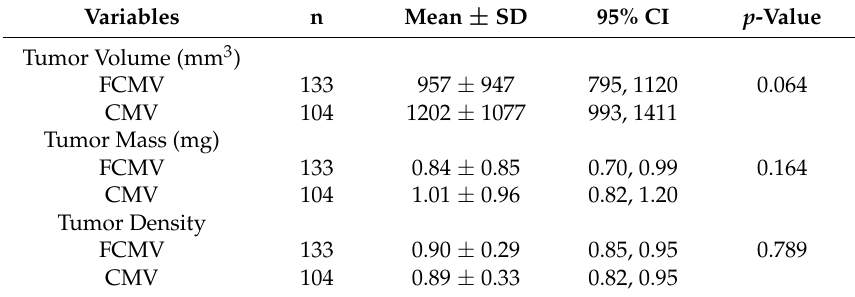
Table 1. The average tumor volume, mass and density in MMTV-PyVT mice with and without a latent mCMV